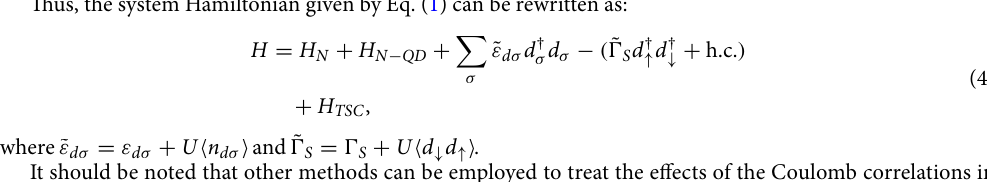
Figure 9. Andreev conductance G A [Eq. (5)] as a function of the bias-voltage for spin symmetric case ( p 2.0 Ŵ 3.0 Ŵ 1.0 Ŵ with (cid:31) L N , Ŵ S = N and eV g = − N . The lines are vertically offset for a better viewing. Solid = orange line corresponds to ideal case of highly nonlocal and nonoverlapping MBSs ( ε M dotted and magenta dashed lines describe the situations of overlapping but well-localized Majoranas ( ε M ε M ), respectively. The case where the overlap between the MBSs and the QD-right MBS and quasi-MBSs ( (cid:31) R ≫ (cid:31) are on equal foot ( ε M R ) is described by the purple dash-dotted =